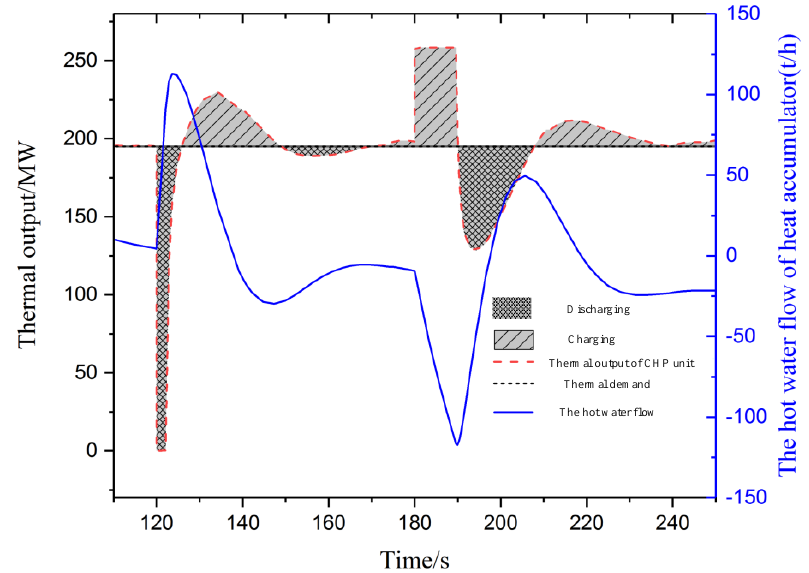
Figure 9. The thermal power output in the process of variable load.